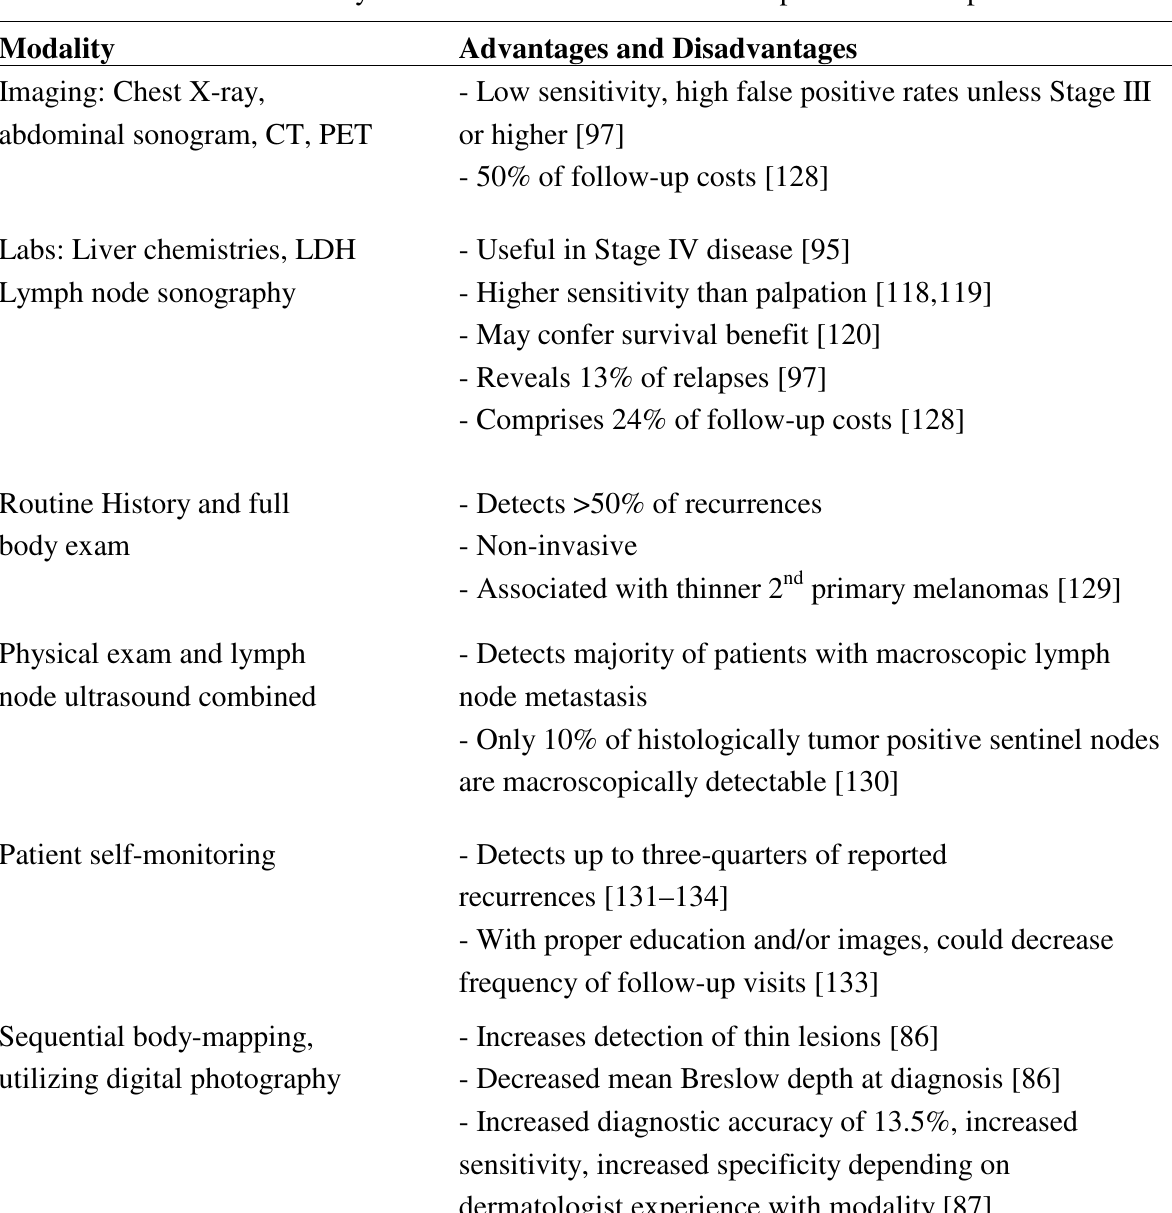
Table 1. Summary of modalities for routine follow-up of melanoma